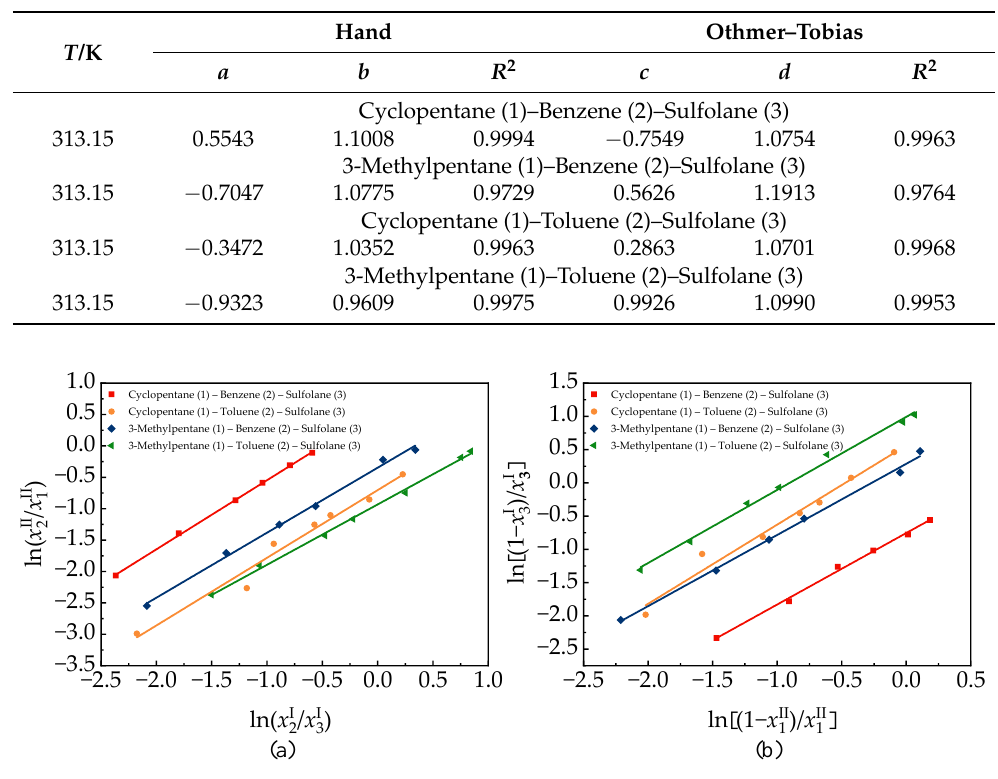
Figure 3. The correlation fitting curves for Hand and Othmer–Tobias equations. ( a ) Hand equation; ( b ) Othmer–Tobias equation.